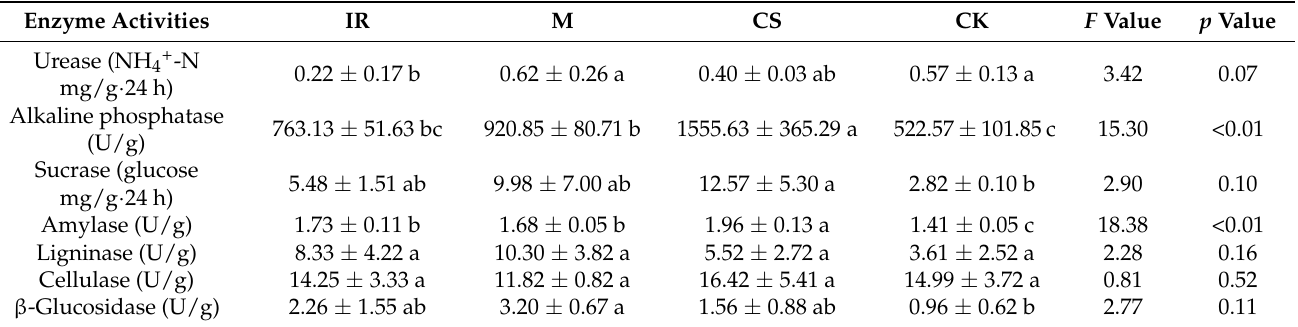
Table 2. Sample plot soil enzyme activity levels.